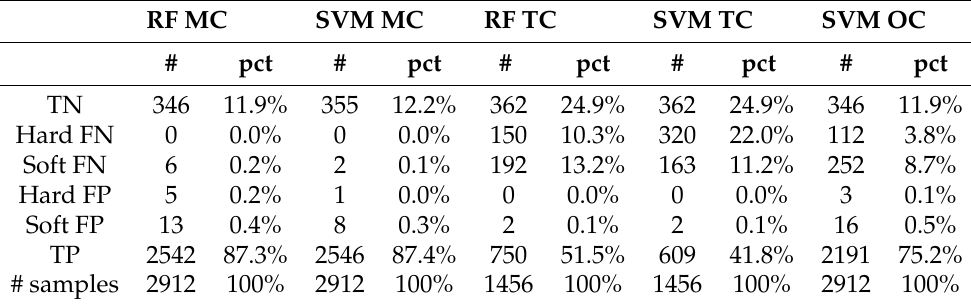
Table 18. Model comparison for the validation